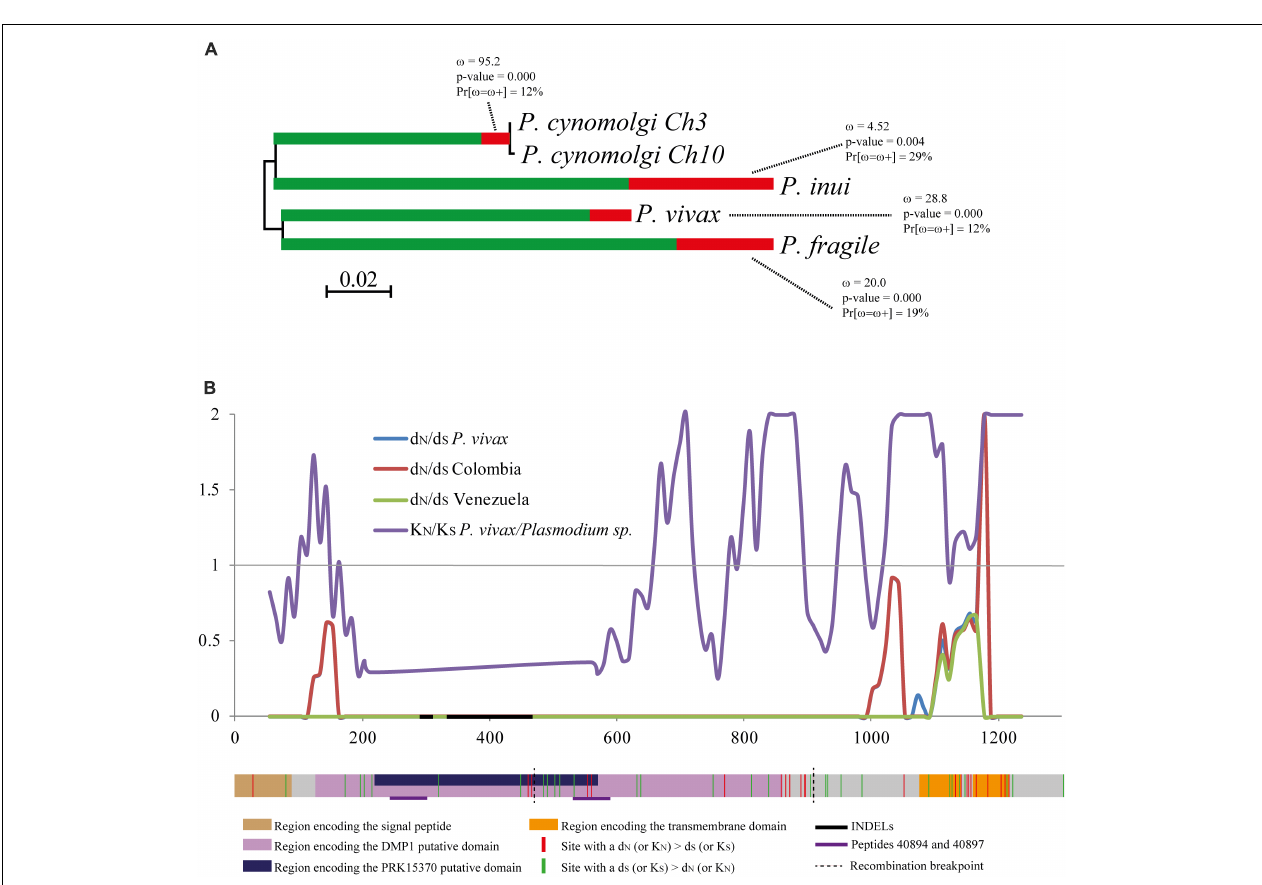
FIGURE 2 | Identifying natural selection signatures in the rbsa gene. (A) A phylogeny tree inferred from pvrbsa CDS and its orthologous CDS was analyzed by the aBSREL method. The shade of each color on branches indicates selection strength [red indicates positive selection ( ω > 1) and green negative selection ( ω < 1)]. The size of each colored segment represents the percentage of selected sites in the corresponding ω class. The Figure shows the ω values, the percentage of positive selected sites (Pr [ ω = ω +]) and p -values. Branches have been classified as undergoing episodic diversifying selection, by the p -value corrected for multiple testing, using the Holm–Bonferroni method at p < 0.05. (B) Representation of the rbsa encoding DNA sequence and the sliding window for the ω rate. The ω rates within P. vivax (d N /d S ) and between the species (K N /K S ) are shown. A gene model of the rbsa gene is given below the sliding window, indicating the sites under purifying selection (green) and positive selection (red). Gene model and numbering were based on the Supplementary Data Sheet 1E alignment.